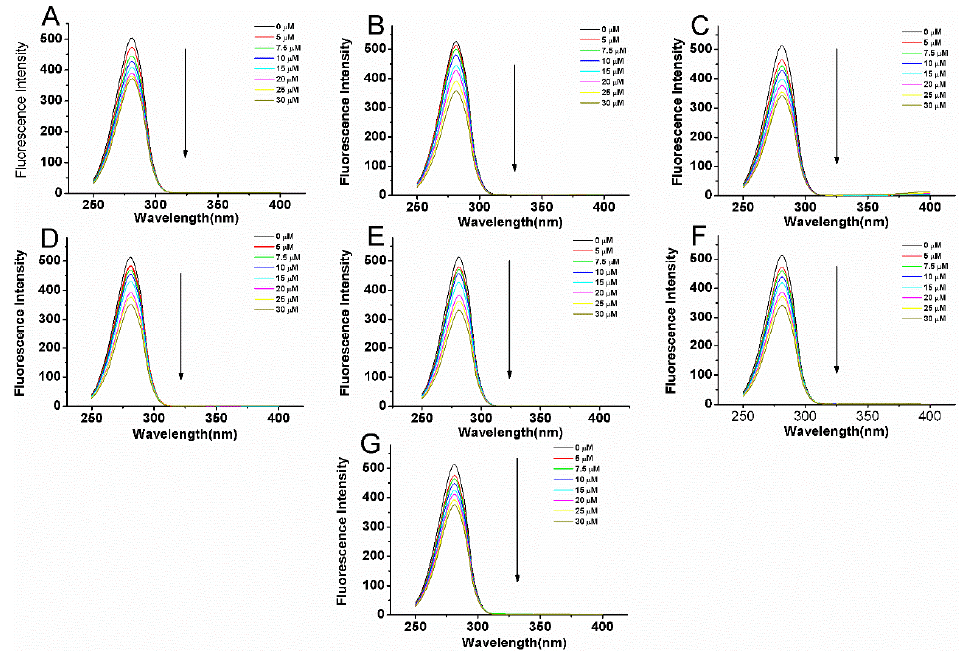
Figure 7. Synchronous fluorescence ( Δλ = 15 nm) of of BSA (5 μ M) with variable concentrations of compounds 1 ( A ), 2 ( B ), 3 ( C ), 4 ( D ), 5 ( E ), 6 ( F ), 7 ( G ) at the excitation wavelength (280 nm) at room temperature in 0.05 mol L − 1 Tris-HCl, pH 7.4. The concentrations of compounds varied from 0 to 30 µ